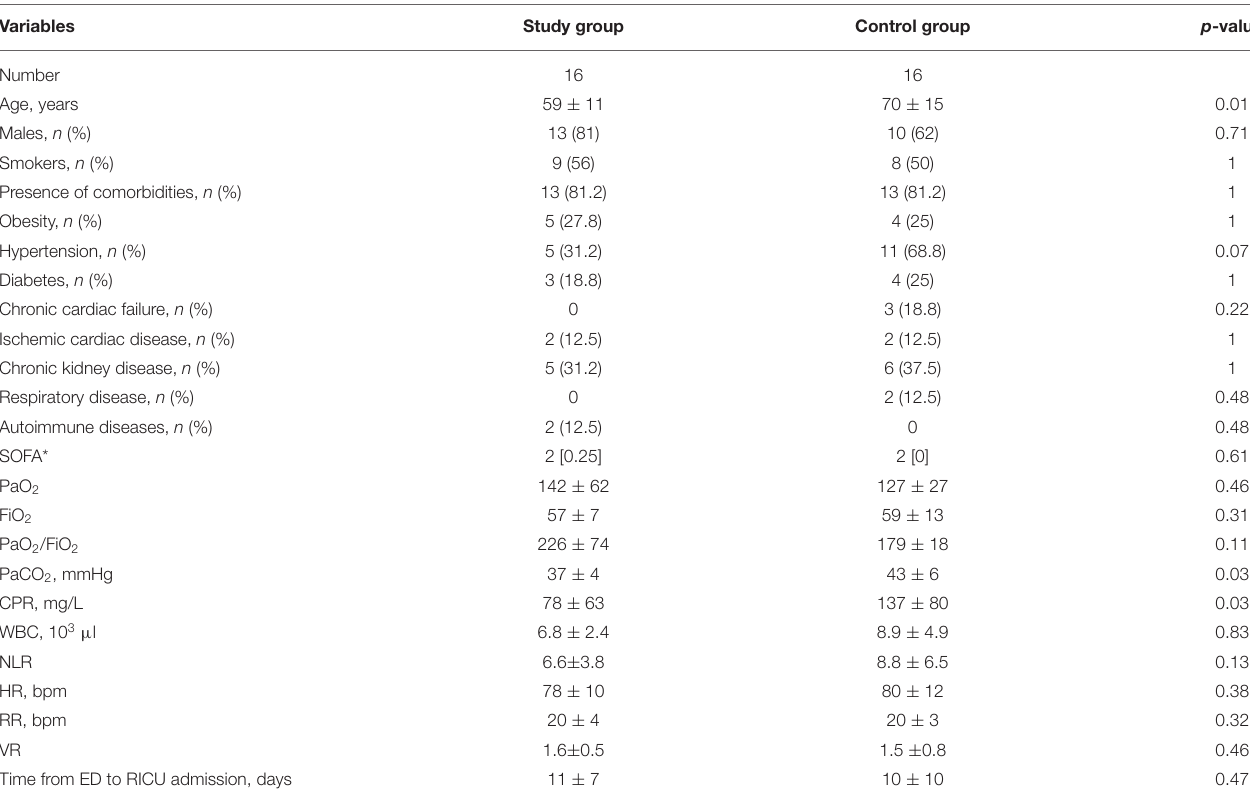
TABLE 1 | Demographic, physiological, and clinical characteristics of patients at RICU admission. Variables Study group Control group p -value